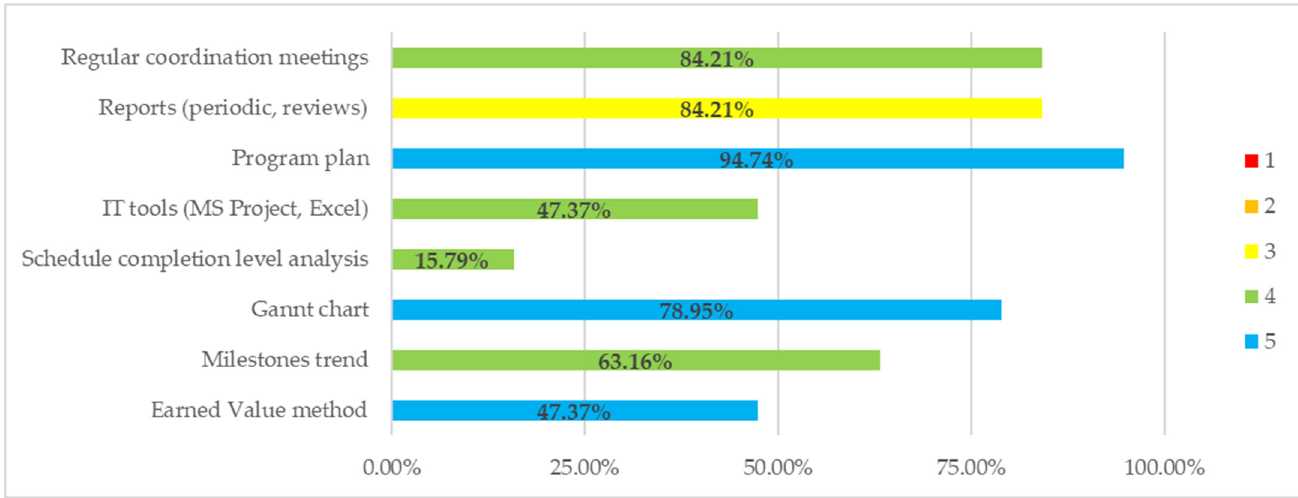
Figure 2. Evaluation of the effectiveness of the methods, techniques and tools used for the schedule control process. Source: own elab.